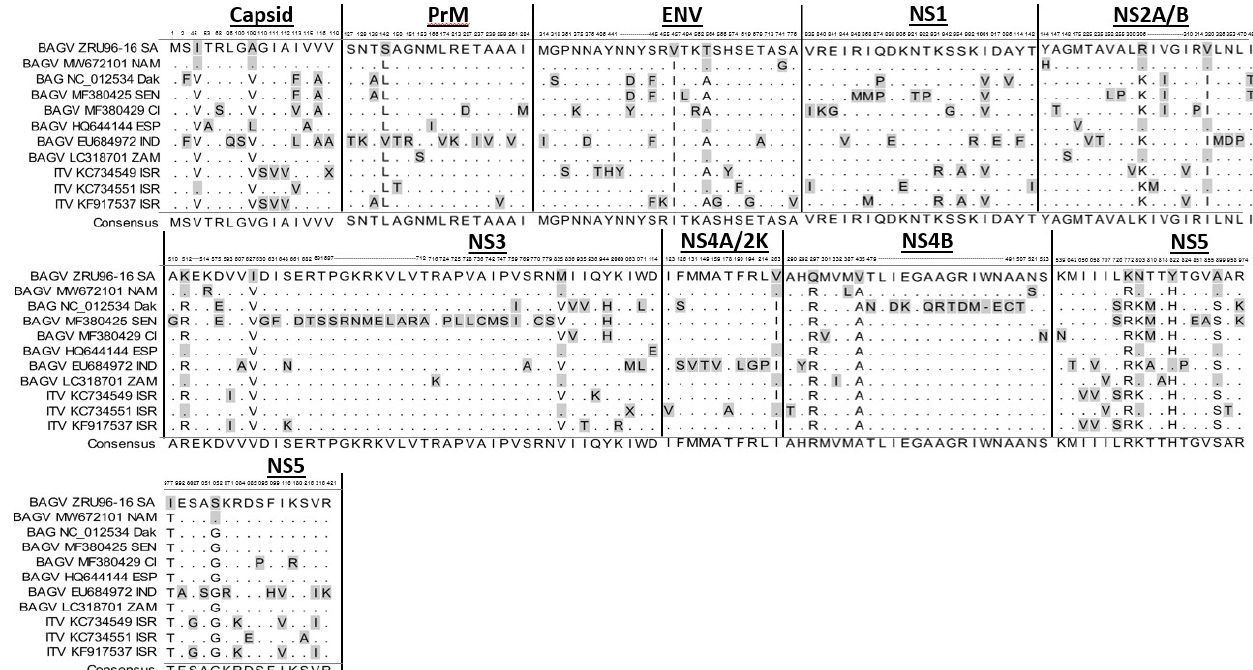
Figure 1. Multiple sequence alignment (MSA) of the polyprotein of selected BAGV and ITV isolates. Eight BAGV sequences, including ZRU96-16, and 3 ITV sequences were compared in an amino acid MSA across the length of the polyprotein. The accession number as well as the location of the isolate is depicted in the name of the sequence. Only amino acid sites in which variation was seen are depicted in the MSA. Amino acids highlighted in grey represent differences from the consensus (Genbank Accession no. MW463911).